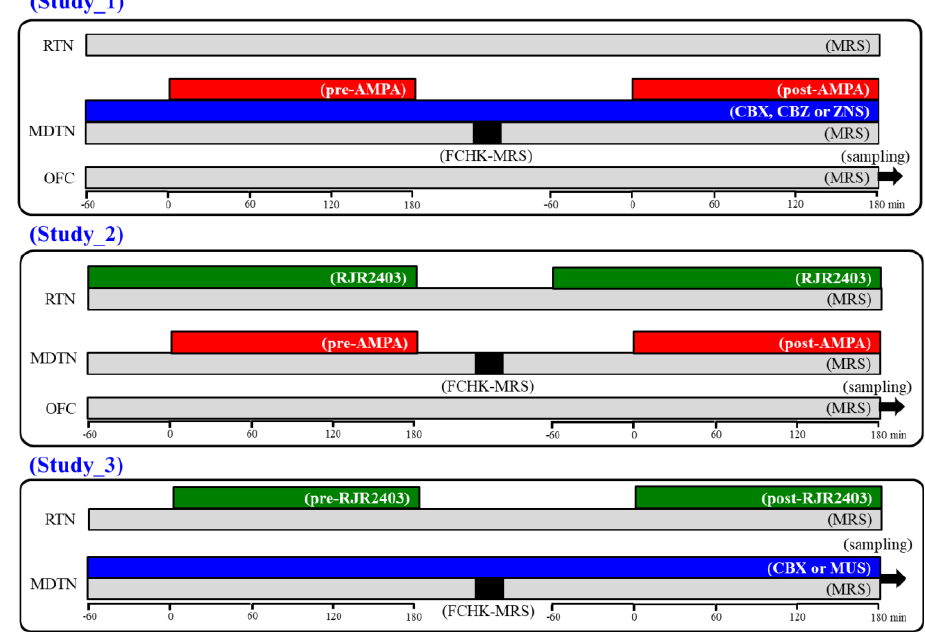
Figure 10. Schematic experimental designs of microdialysis. MRS: modified Ringer’s solution (gray columns), FCHK-MRS: Ca 2+ -free with 100 mM K + containing MRS (closed columns), RJR2403 (100 μ M: selective α 4 β 2-nAChR agonist): (E)- N -Methyl-4-(3-pyridinyl)-3-buten-1-amine oxalate, AMPA (100 μ M: AMPA/glutamate receptor agonist): amino-3-(3-hydroxy-5-methyl-isoxazol-4-yl) propanoic acid, CBX (100 μ M: non-selective hemichannel inhibitor): carbenoxolone, CBZ (100 μ M): carbamazepine, MDTN: mediodorsal thalamic nuclei, RTN: reticular thalamic nucleus, OFC: orbitofrontal cortex, and ZNS (500 μ M): zonisamide.